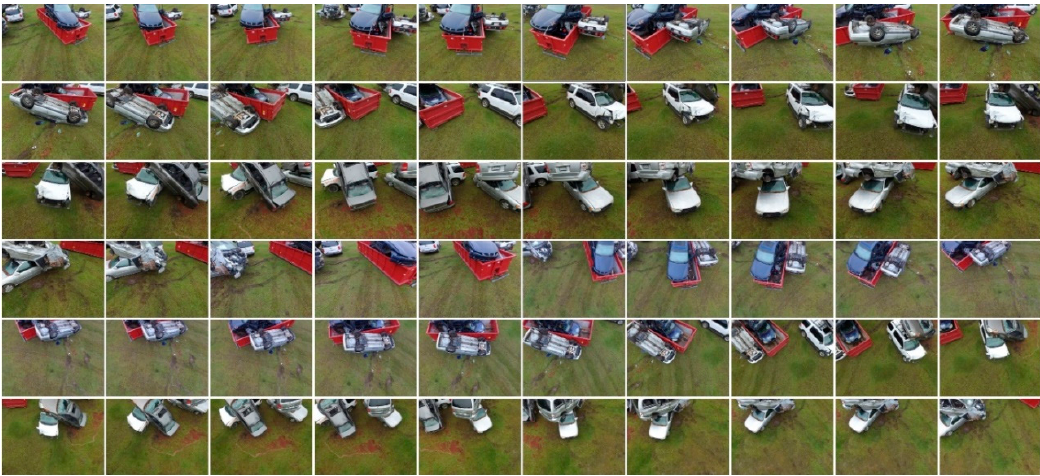
Figure 12. Samples from the Forensic dataset. Note that many repeating features are appeared on the surface of each